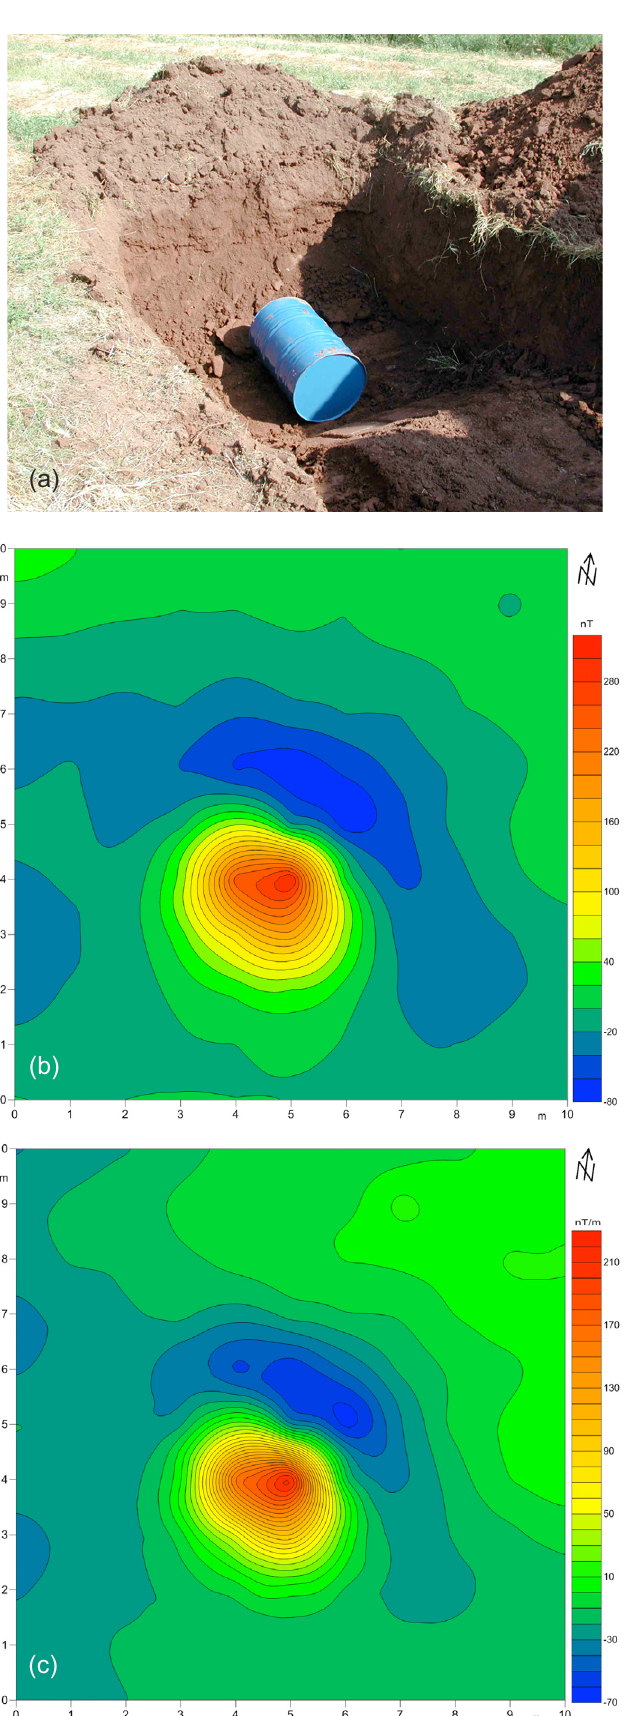
Figure 5. A single drum buried horizontally. The magnetic inclination was around 58º. (a) Photograph of the preparation of the underground target. (b) Anomaly map of the total intensity field. (c) Map of vertical gradient.